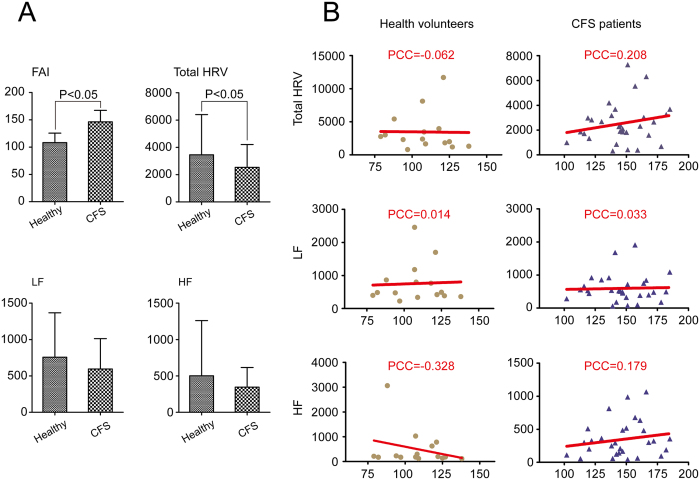
correlation between FAI scores and HRV parameters.(A) The difference between healthy volunteers and CFS patients in FAI and HRV indices. Compared with the healthy volunteers, the quantitative value of total HRV was significantly lower and FAI scores was significantly higher in CFS patients (P < 0.05). (B) The correlation coefficient between HRV indices and FAI scores. All the HRV indices had a weak correlation with the level of fatigue either in the CFS patients or health volunteers. Total HRV and HF in CFS patients as well as HF in health volunteers showed a closer correlation than other parameters. (PCC: Pearson correlation coefficient, X axis in Figure (4b) represent the FAI scores).